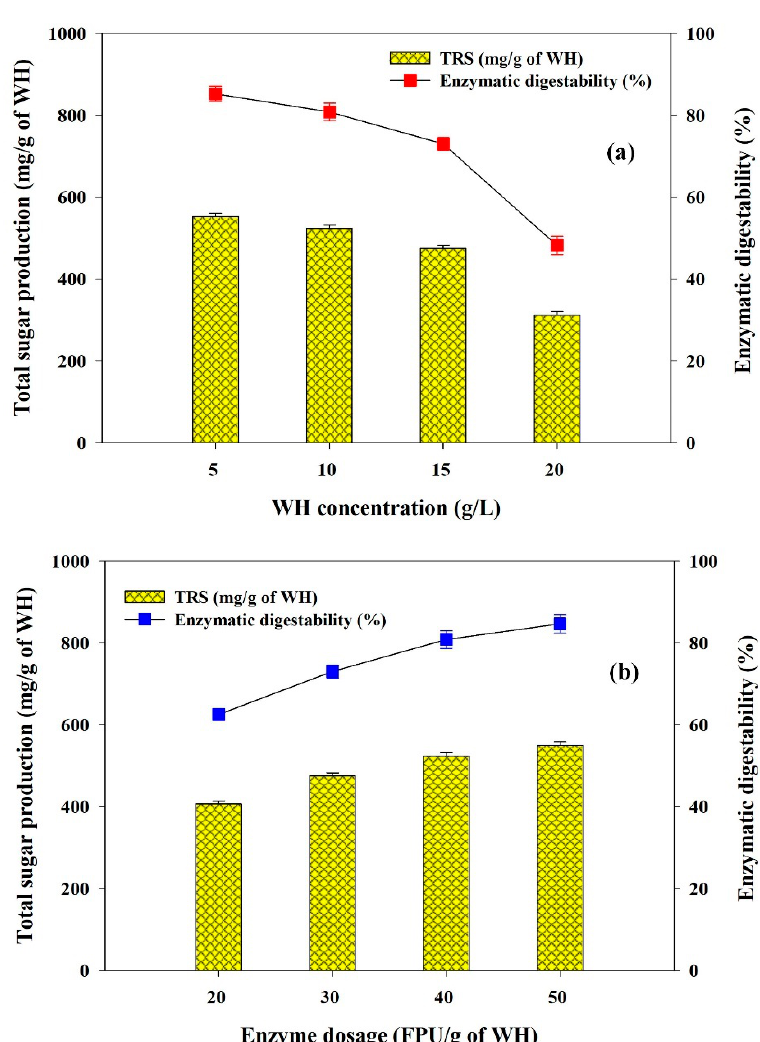
Figure 2. Effects of ( a ) substrate concentration (WH biomass) and ( b ) enzyme loading (FPU/g of WH) on enzymatic digestability and total reducing sugar production from WH.